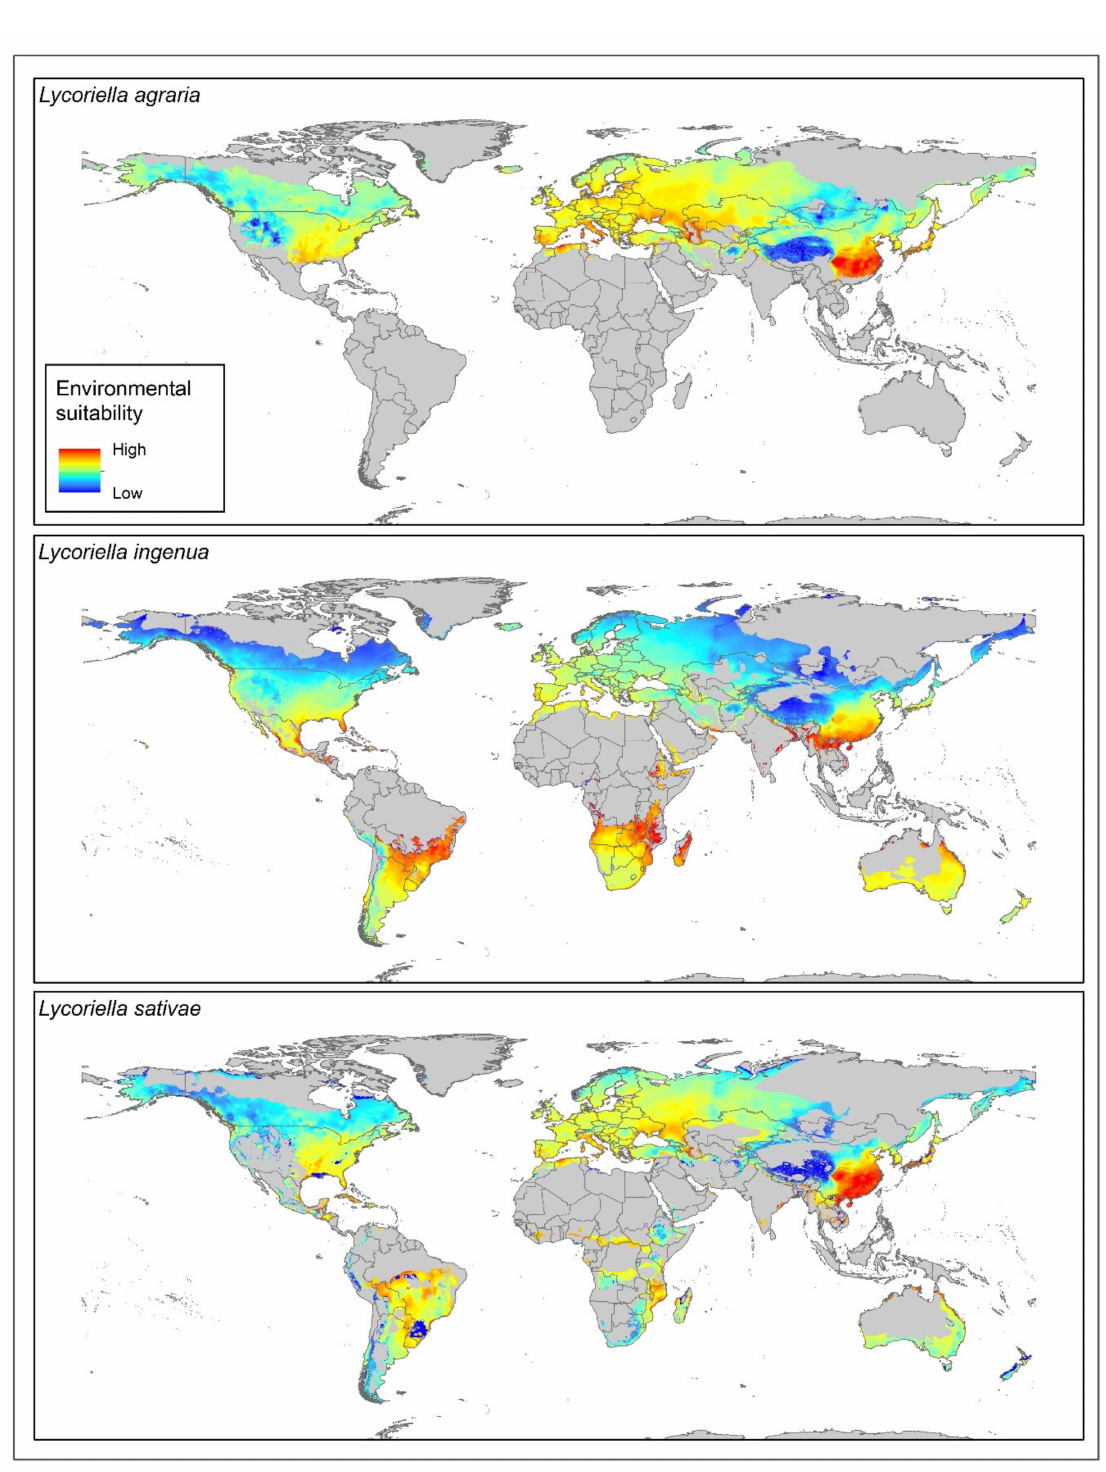
Figure 2. Environmental suitability for three Lycoriella species under current climate conditions